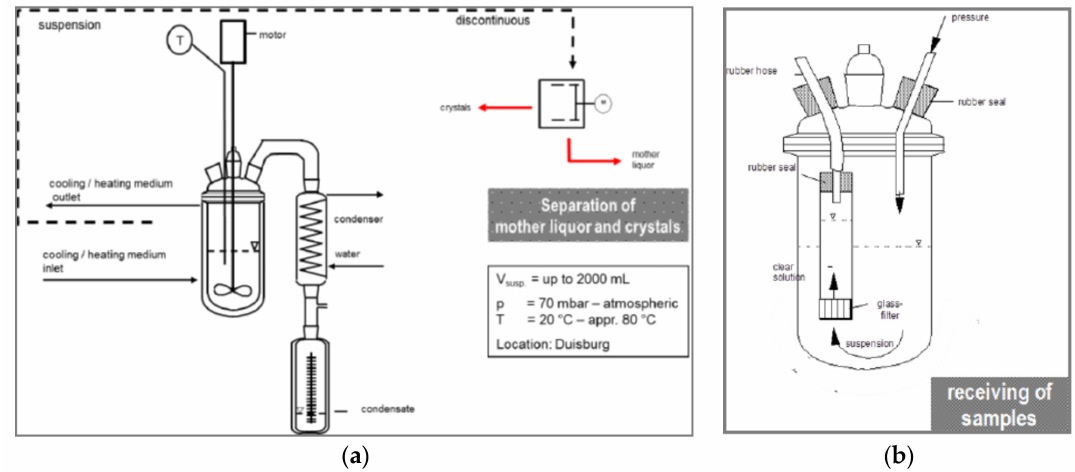
Figure3. ( a )Experimentalsetupfordiscontinuousmulti-stagecrystallizationtests; ( b )samplingprocedure.